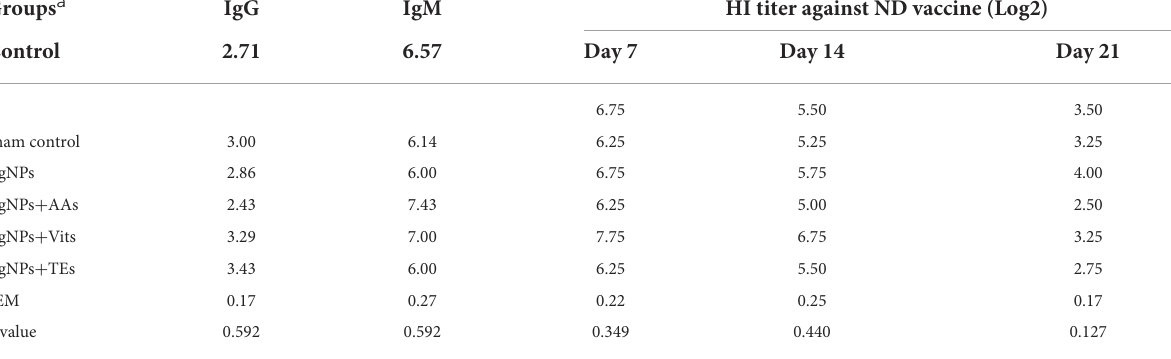
TABLE 4 Effect of in ovo administration of silver nanoparticles (AgNPs) and critical nutrients on the mercapto-ethanol-resistant (IgG) and sensitive (IgM) antibodies. Groups a